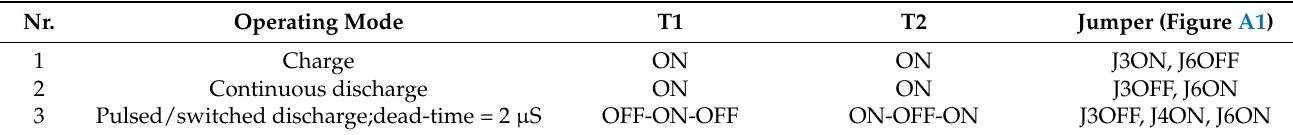
Table A1. SWD device operating mode.